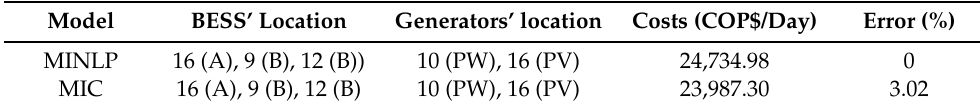
Table 10. Numerical results for the MIC and the MINLP models in Case